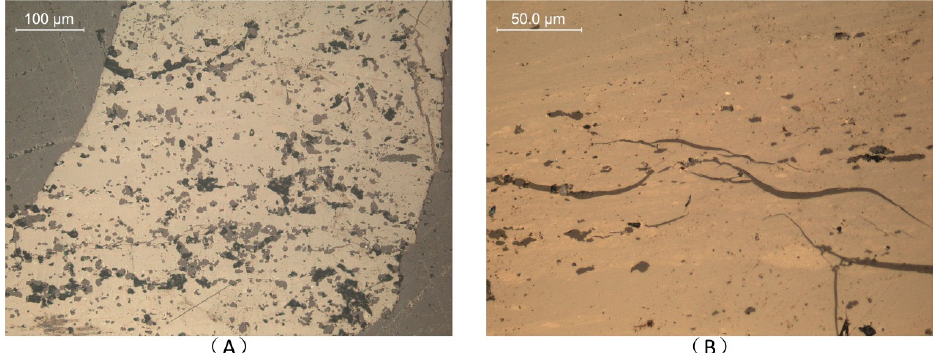
Figure 6. Quartz in sample C19-1. ( A ) Particles of quartz; ( B ) fracture-filling quartz. Optical microscope, reflected light.